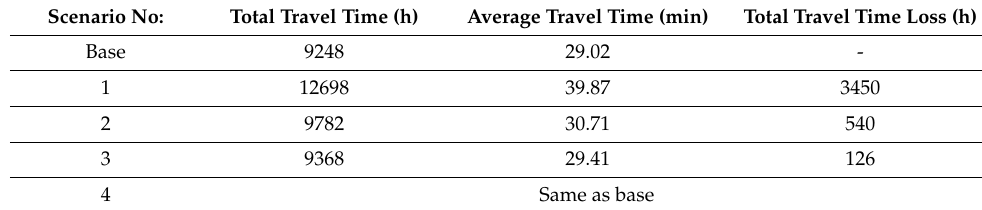
Table 14. Daily travel time loss before and after (day 0).